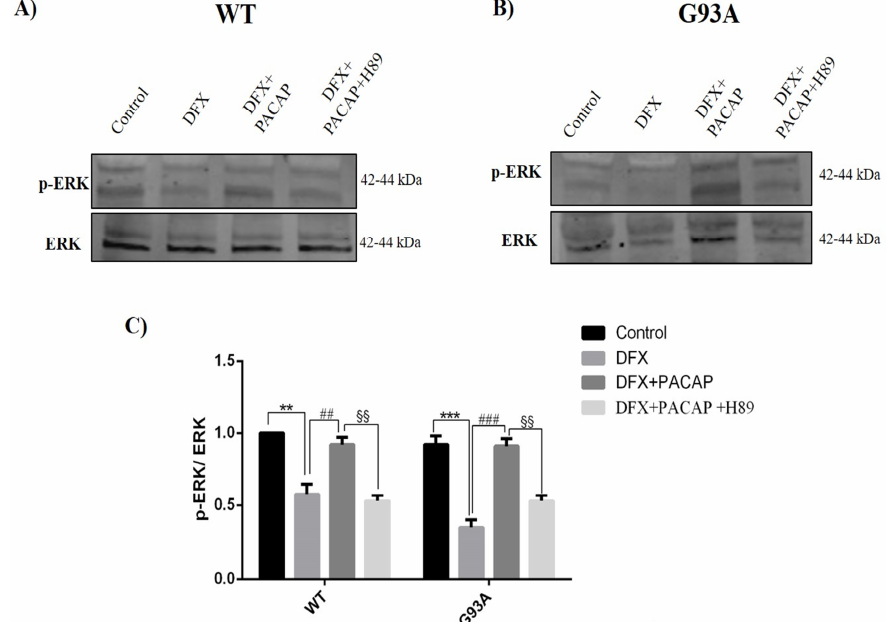
Figure 6. E ff ect of PACAP on ERK phosphorylation in the WT and G93A cells 24h after hypoxia exposure. ( A , B ) Representative immunoblots of the signals detected by the p-ERK / ERK antibody on the WT and G93A cell homogenates cultured for 24h in desferrioxamine mesylate salt (DFX) alone or in combination with PACAP (DFX + PACAP) or PACAP + H89 (DFX + PACAP + H89). ( C ) The bar graph show the results of three independent experiments. The ImageJ software was used to quantify the relative band density of the p-ERK / ERK protein levels. Data are expressed as a mean ± SEM of values normalized to the WT / control data set to 1.0 (** p < 0.01 or *** p < 0.001 vs. WT or G93A control, ## p < 0.01 or ### p < 0.001 vs. WT DFX and G93A DFX and §§ p < 0.01 vs. WT and G93A DFX + PACAP as determined by a one-way ANOVA followed by Tukey’s post-hoc test). To investigate whether the modulatory e ff ect of PACAP on autophagy was mediated by the induction of the MAPK / ERK signaling pathway, we analyzed the LC3II expression in the DFX-treated WT and G93A cells following the peptide treatment alone (DFX + PACAP) or in co-treatment with H89 (DFX + PACAP + H89). As previously shown (Figure 4), the expression of LC3II was significantly increased in G93A DFX-treated respect to control ( §§§ p < 0.001 vs. G93A control) and its expression was decreased in the G93A cells treated with DFX + PACAP as compared to the DFX-treated group (Figure 7C, ### p < 0.001 vs. G93A DFX). The co-administration of H89 in G93A cells exposed to hypoxia significantly increased the LC3II levels with respect to the DFX + PACAP treated group (Figure 7C, ◦◦◦ p < 0.001 vs. G93A DFX + PACAP), suggesting that PACAP-modulated autophagy was mediated through the MAPK / ERK signaling cascade